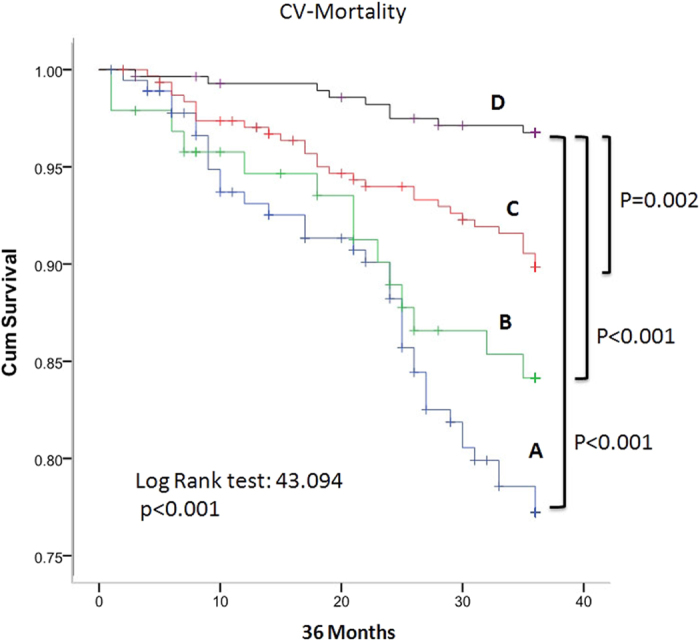
Cumulative survival rates based on cardiovascular mortality and different groups of hemodialysis patients.CV: cardiovascular; (A–D) Group (A–D) patients.